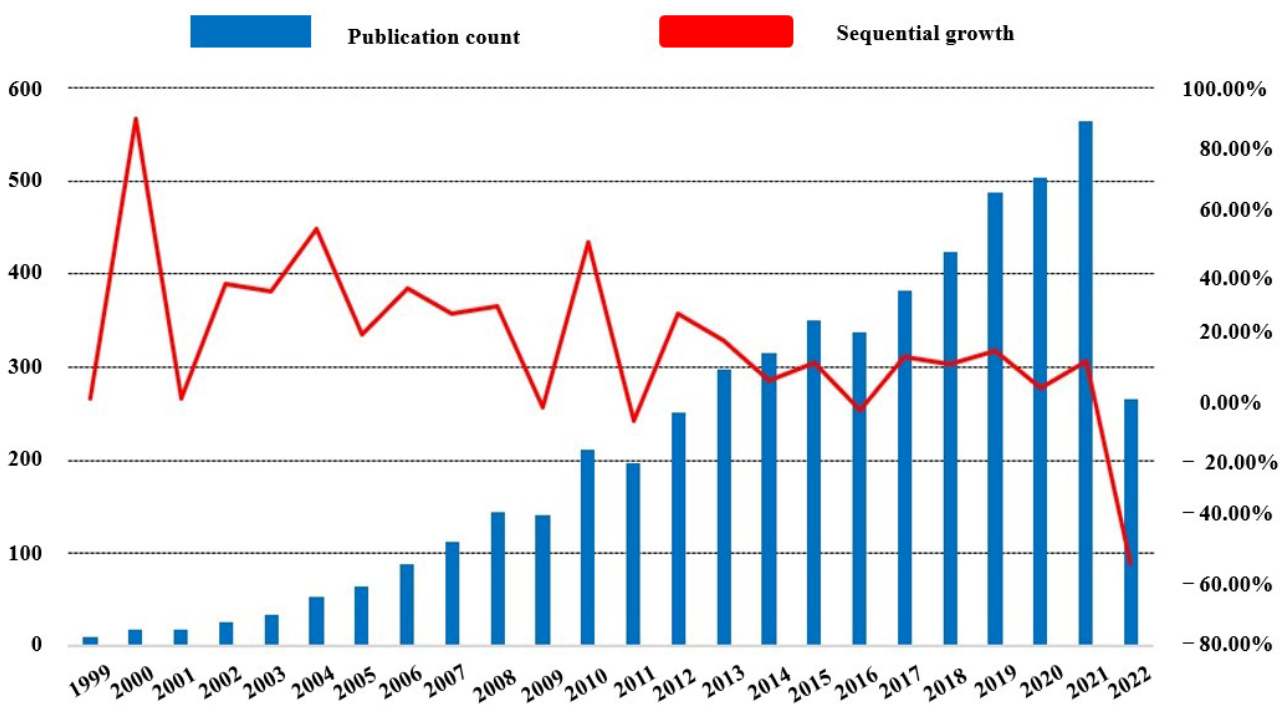
Figure 2. Annual publications and trends. Global trends and sequential growth rate of annual publications related to Depression and BDNF